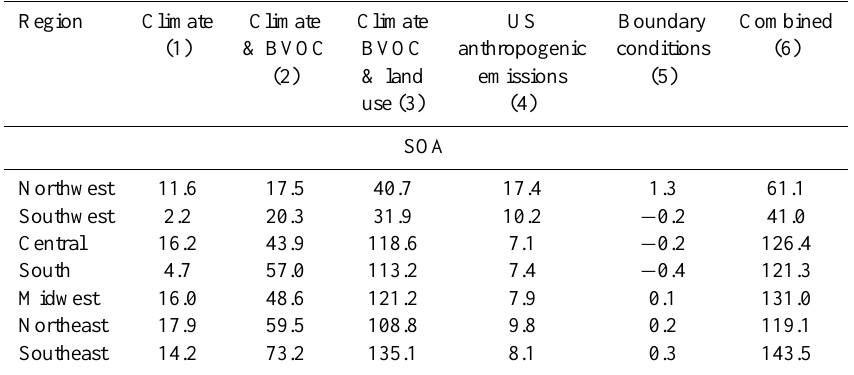
Table 4. Percent change of SOA between each future scenario and the current decade base case. The corresponding simulation number for each sensitivity simulation is shown in parenthesis,